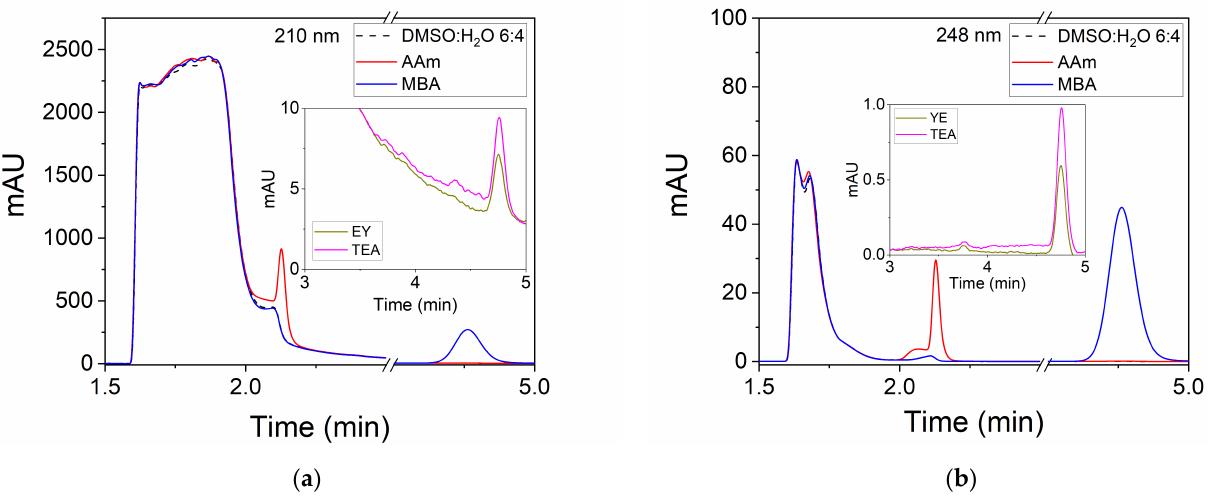
Figure 3. Chromatogram (mAU = mili OD at 210 nm) of washing solutions: ( a ) W1, W2 and W3; ( b ) W4, W5 and W6. Detection is carried out by absorption measurements at 210 nm; ( c ) Chromatogram area for AAm (black filled squares) and MBA (empty red circles) at 210 nm; ( d ) UV-Visible absorption spectra of incubator solution (IS) and washing solutions. Inset: Absorbance at 517 nm in the washing solutions. The solvent used is PBST.